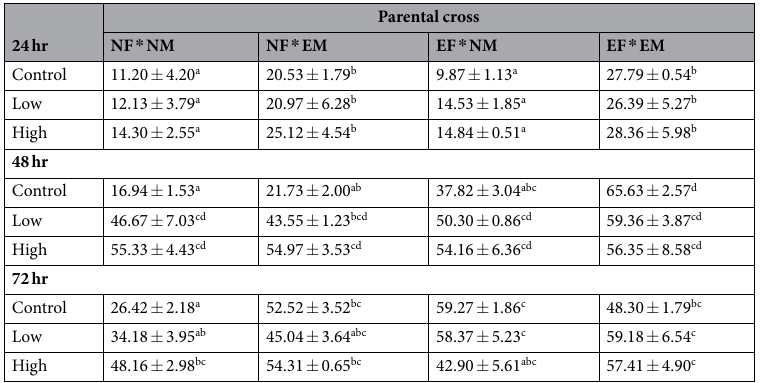
Table 2. Mean ± SE percentage abnormality in 24, 48 and 72 hr-old Evechinus chloroticus embryos exposed to control (0 ng/L), low (540 ng/L) and high (1080 ng/L) PAH doses. Embryos were derived from contaminant- naïve versus contaminant-experienced parents, and combinations of both (e.g. NF * NM = naïve female crossed with naïve male). N = grand mean of 3 counts (40–60 embryos per count). Different letters indicate significant treatment effects ( P < 0.05) using multiple comparisons testing (Tukey’s